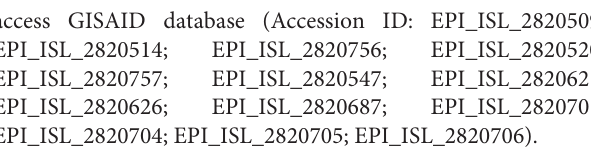
using Nextclade (https://clades.nextstrain.org/) (20) and an in-house Python